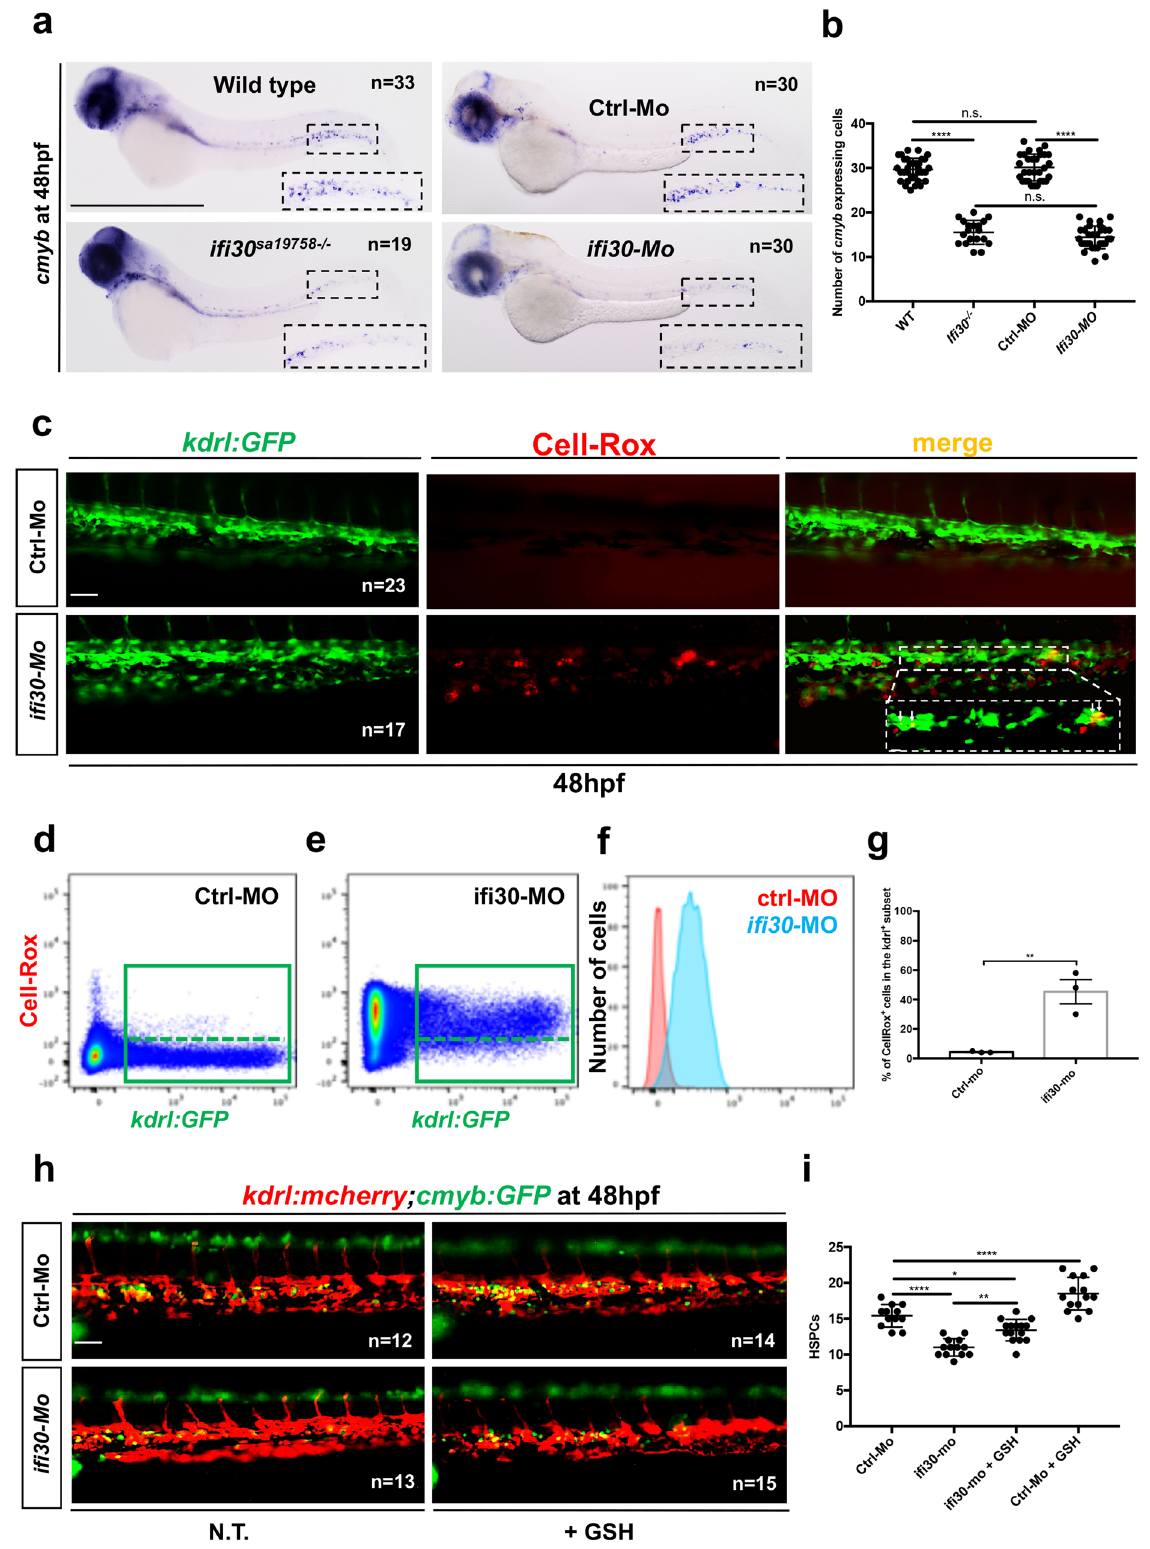
creating a premature STOP codon (Supplementary Fig. 13a). We found that cx41.8 − / − mutants showed normal HSPC speci fi